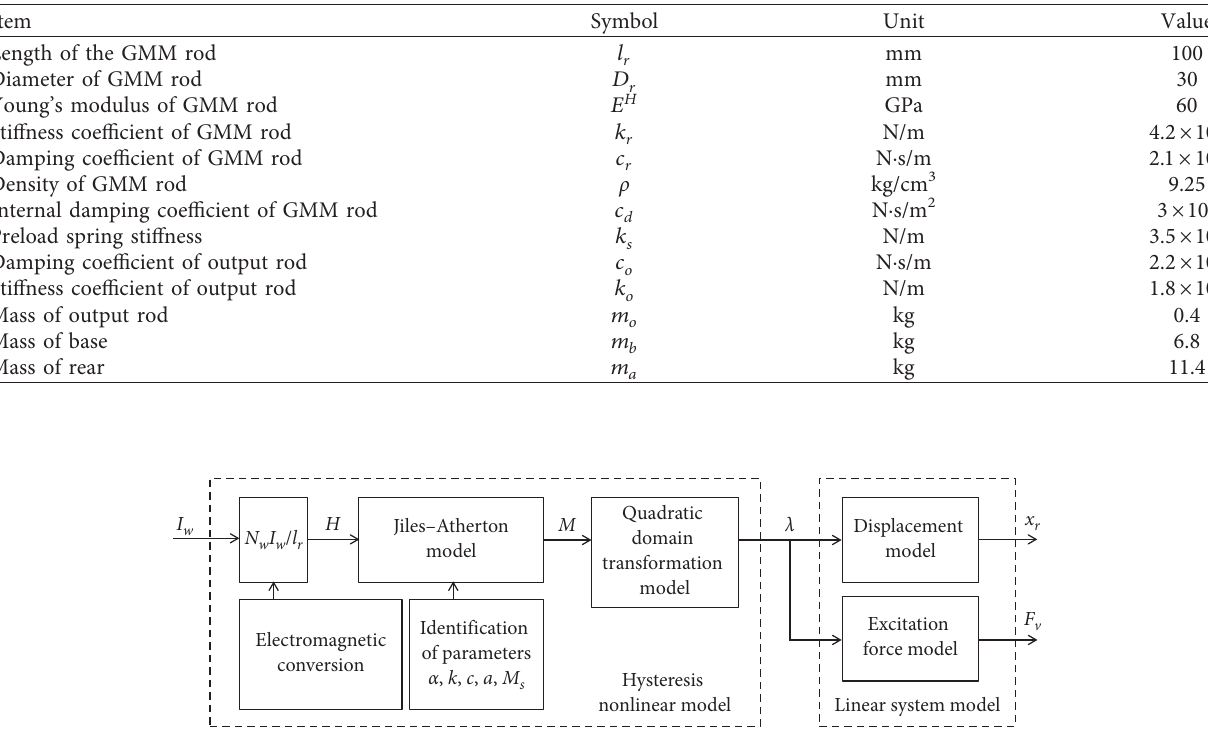
Figure 4: System model structure diagram of the GMV.